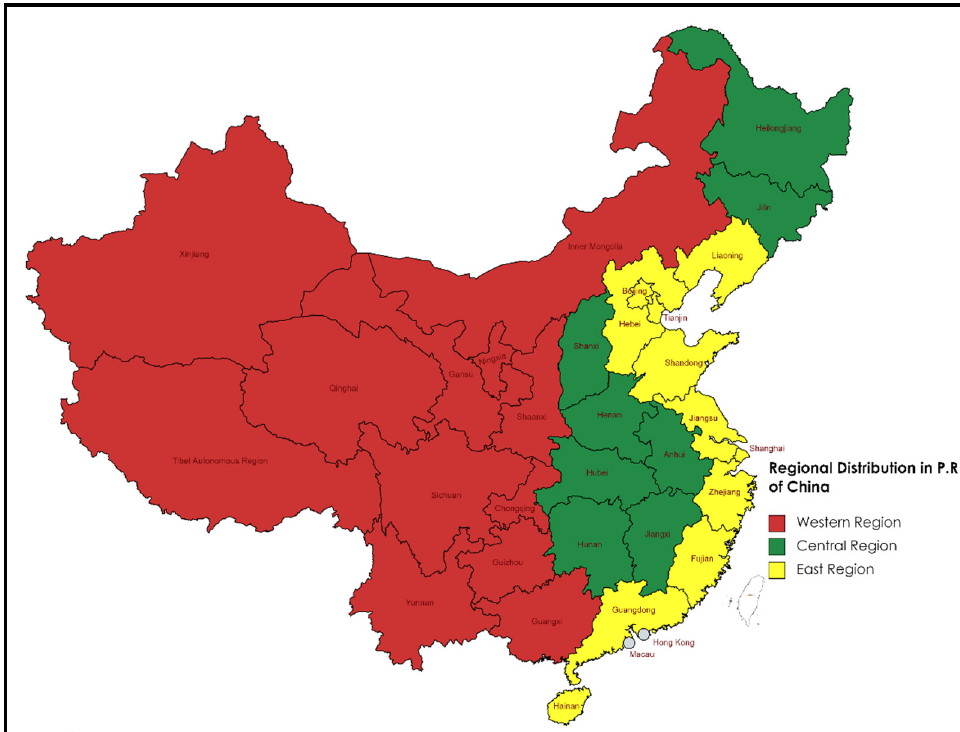
Figure 1. Central, western, and eastern regions in China.